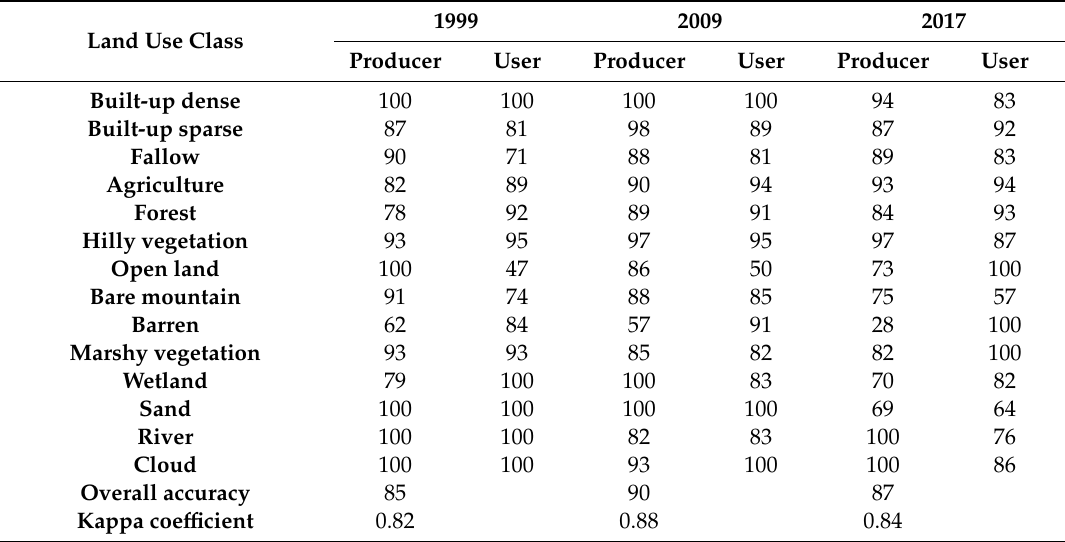
Table 2. Accuracy assessment (producer’s and user’s accuracy in %), overall accuracy (in %) and kappa coe ffi cient computed using bootstrapping method (100